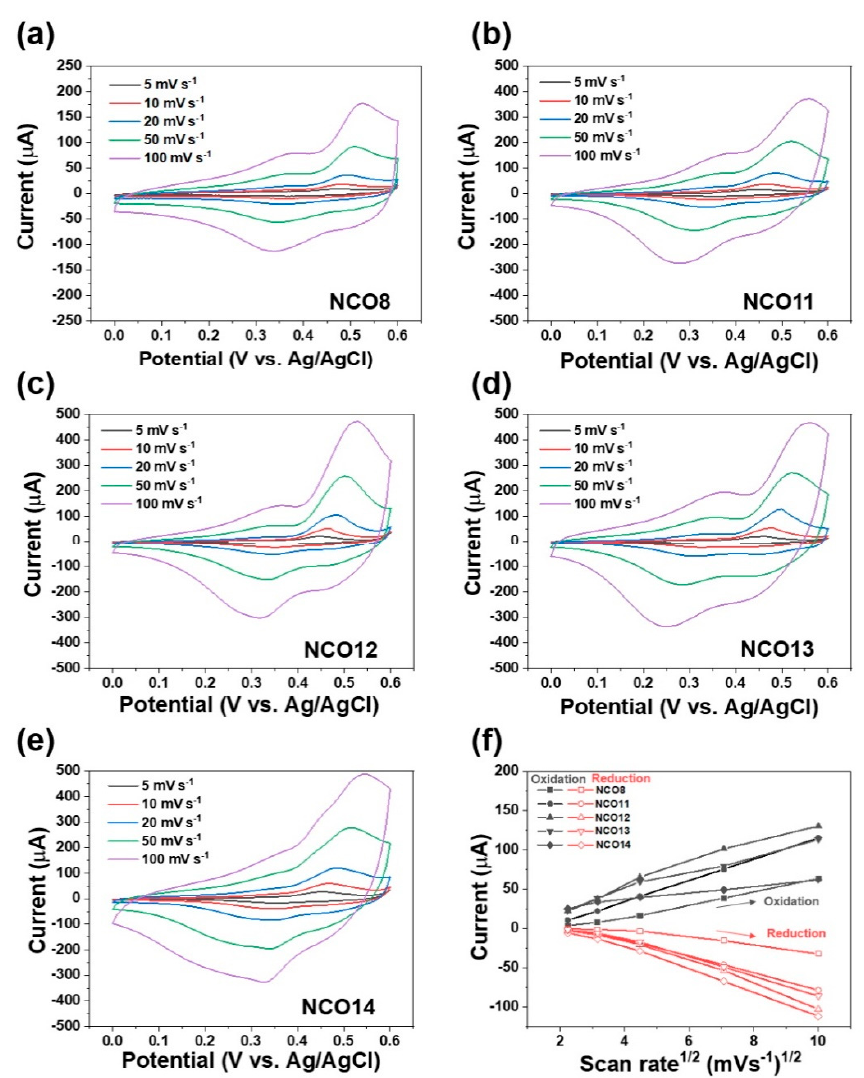
Figure 3f. All NCOs synthesized at different pH show a linear proportionality relationship between the redox peak currents and the square root of the scan rates, suggesting that NCOs undergo diffusion-controlled electrochemical behavior [38,39]. Also, CV responses of NCOs were synthesized at different pH in response to 5 mM glucose under alkaline conditions (0.1 M NaOH) at a scan rate of 50 mVs − 1 , as shown in Figure S3. Regardless of the pH, all NCOs oxidize glucose (C 6 H 12 O 6 ) to gluconolactone (C 6 H 10 O 6 ), which im- plies that NCOs synthesized at different pH can be applied to electrochemical glucose sensors [40,41].